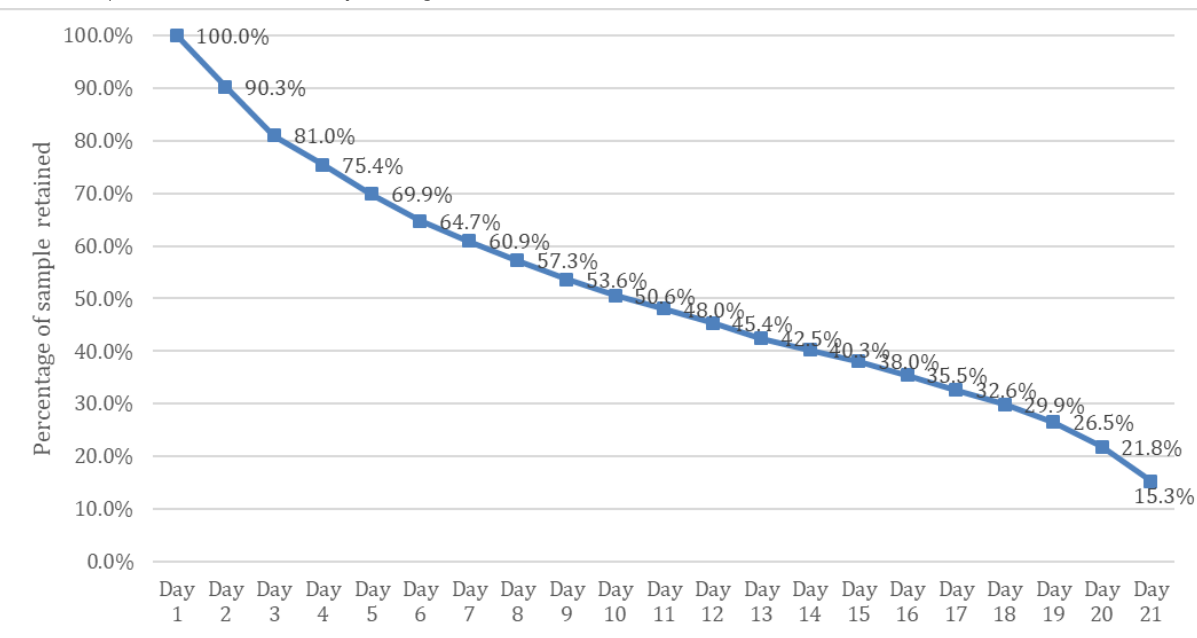
Figure 5. Participant attrition over the 21-day challenge (n=4683).